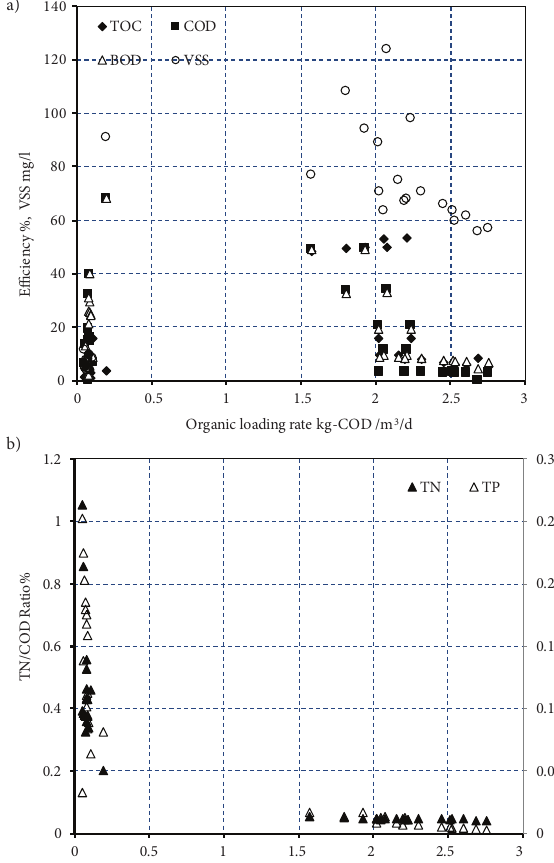
Figure 4. Hybrid biological reactor performance under high flow-low oxygen scenario: a) organics removal efficiency and VSS concentration versus organic loading rate; b) TN/COD, TP/COD, versus organic loading rate